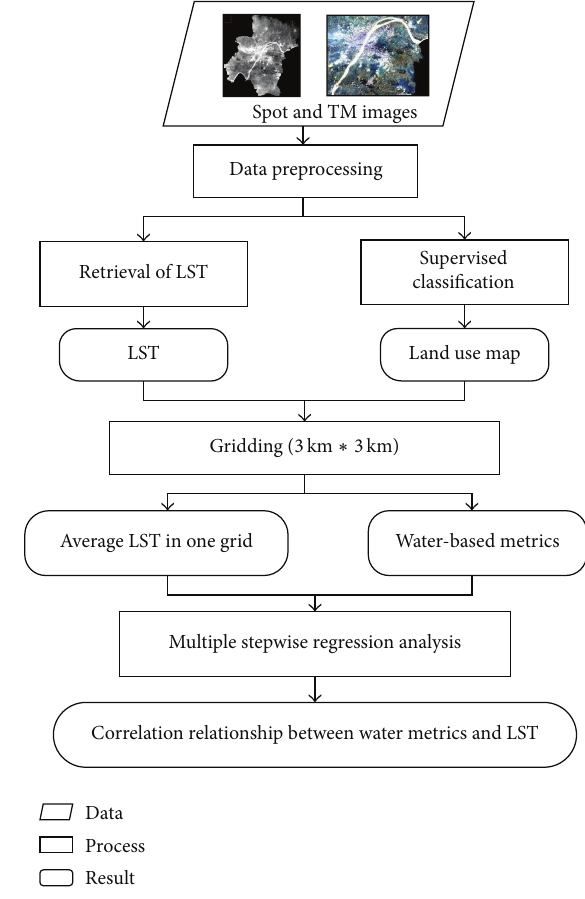
Figure2:Researchframeworkoflandscapemetricsofwateronland surface